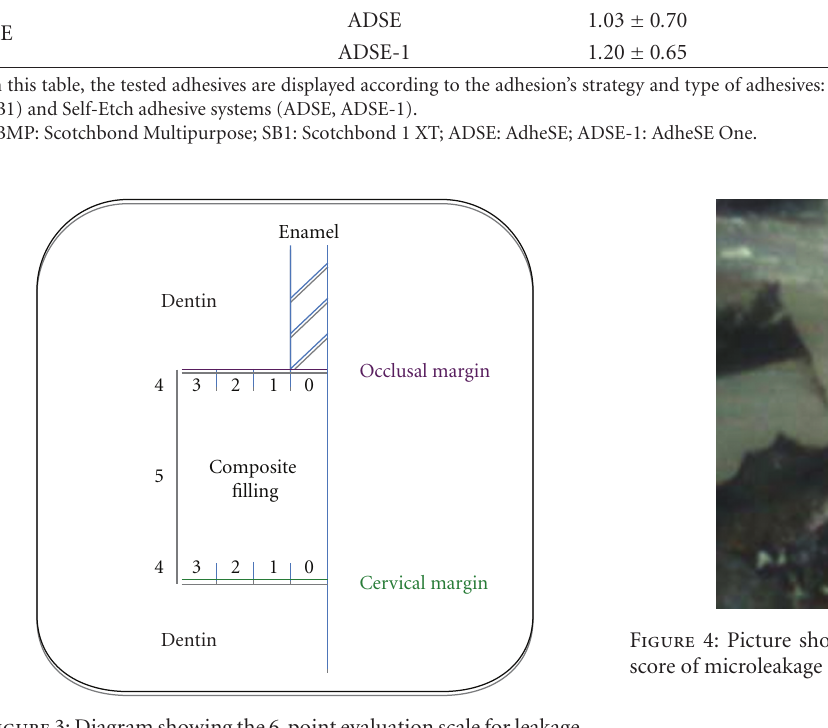
Figure 3: Diagram showing the 6-point evaluation scale for leakage.